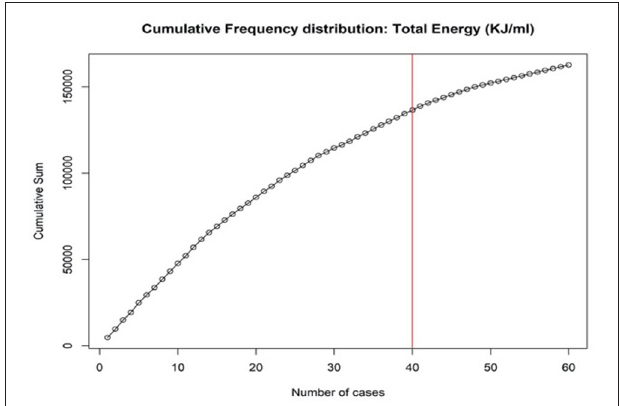
FIGURE 2 | Cumulative summation analysis of total energy per ml of prostate volume during the training process.